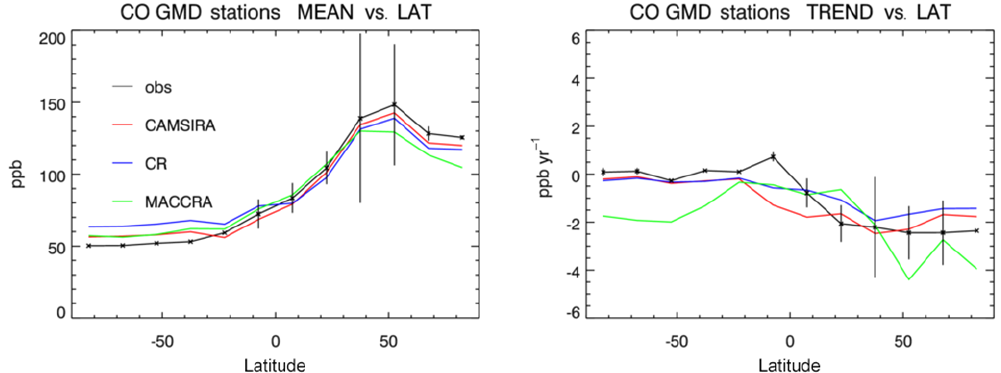
Figure 6. Zonal average of mean surface CO in ppb observed at NOAA-GMD stations (2003–2014), values from CAMSiRA, the CR, and MACCRA (2003–2012) (left) and zonal median of linear trend in ppbyr − 1 (right). The error bars indicate the range of the observed